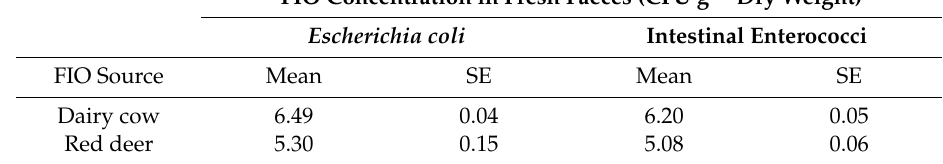
Table 1. FIO concentrations in fresh faeces from the dairy cow and red deer sources used in this experiment.